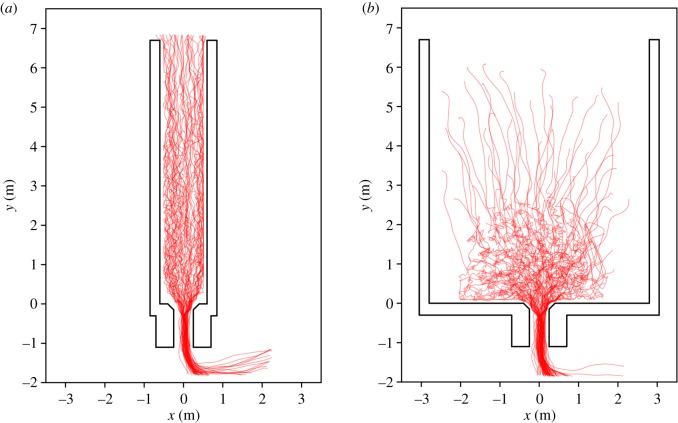
Trajectories of Run 110 with w = 1.2 m (a) and Run 030 with w = 5.6 m (b).